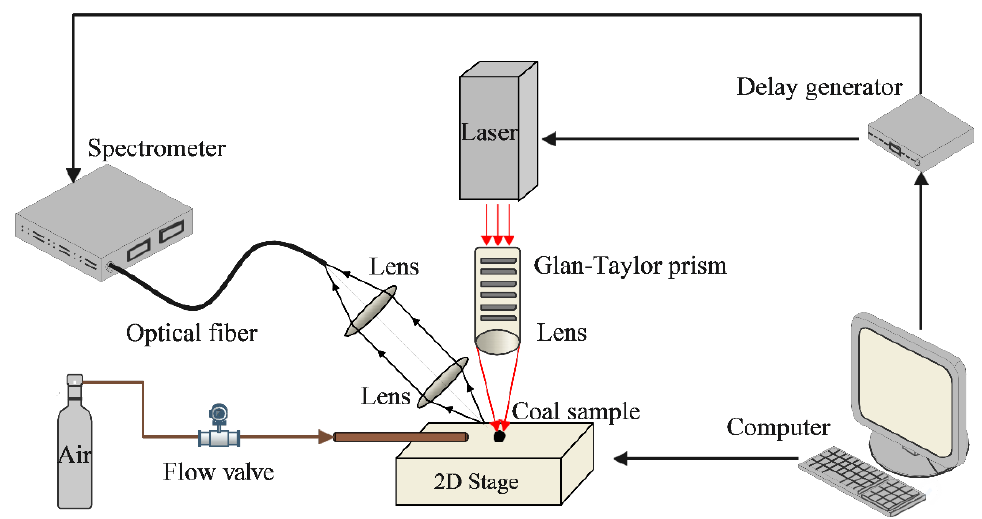
Figure 1. Schematic of the LIBS experimental setup.